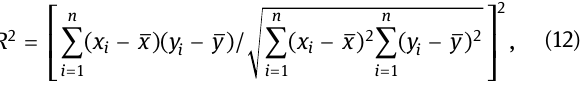
Figure 7: The regression of observed and calculated discharge after 15 iterations in the ANFIS fraction of the dependent variable ’ s variation that can be predicted from the independent factors. It typically runs from 0 to 1.